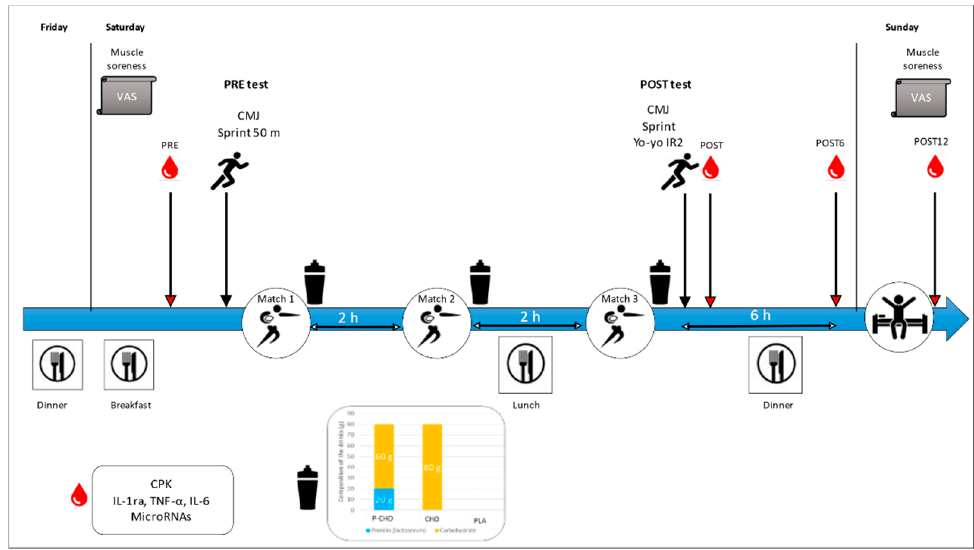
Figure 1. Experimental study design overview. Participants followed the same protocol for 3 consecutive weekends. The only difference was the drink consumed after each match: PLA, placebo drink; CHO, carbohydrate drink; P-CHO, protein and carbohydrate isoenergetic drink. PRE, pretournament tests; POST, post-tests at the end of the third simulated rugby 7s match; VAS: visual analog scale; CPK: creatine phosphokinase; IL-1ra, interleukin-1 receptor antagonist; TNF- α , tumor necrosis factor-alpha; IL-6, interleukin-6; CMJ, countermovement jump, Yo-Yo IR2, Yo-Yo intermittent recovery test 2. Blood samples were collected at four different time points: PRE, just after the end of the post-tests (POST), 6 h after the tests (POST6) and 12 h after the tests (POST12). All participants followed the same protocol for three consecutive weekends. Physical activity, sleep and alcohol consumption were controlled during the